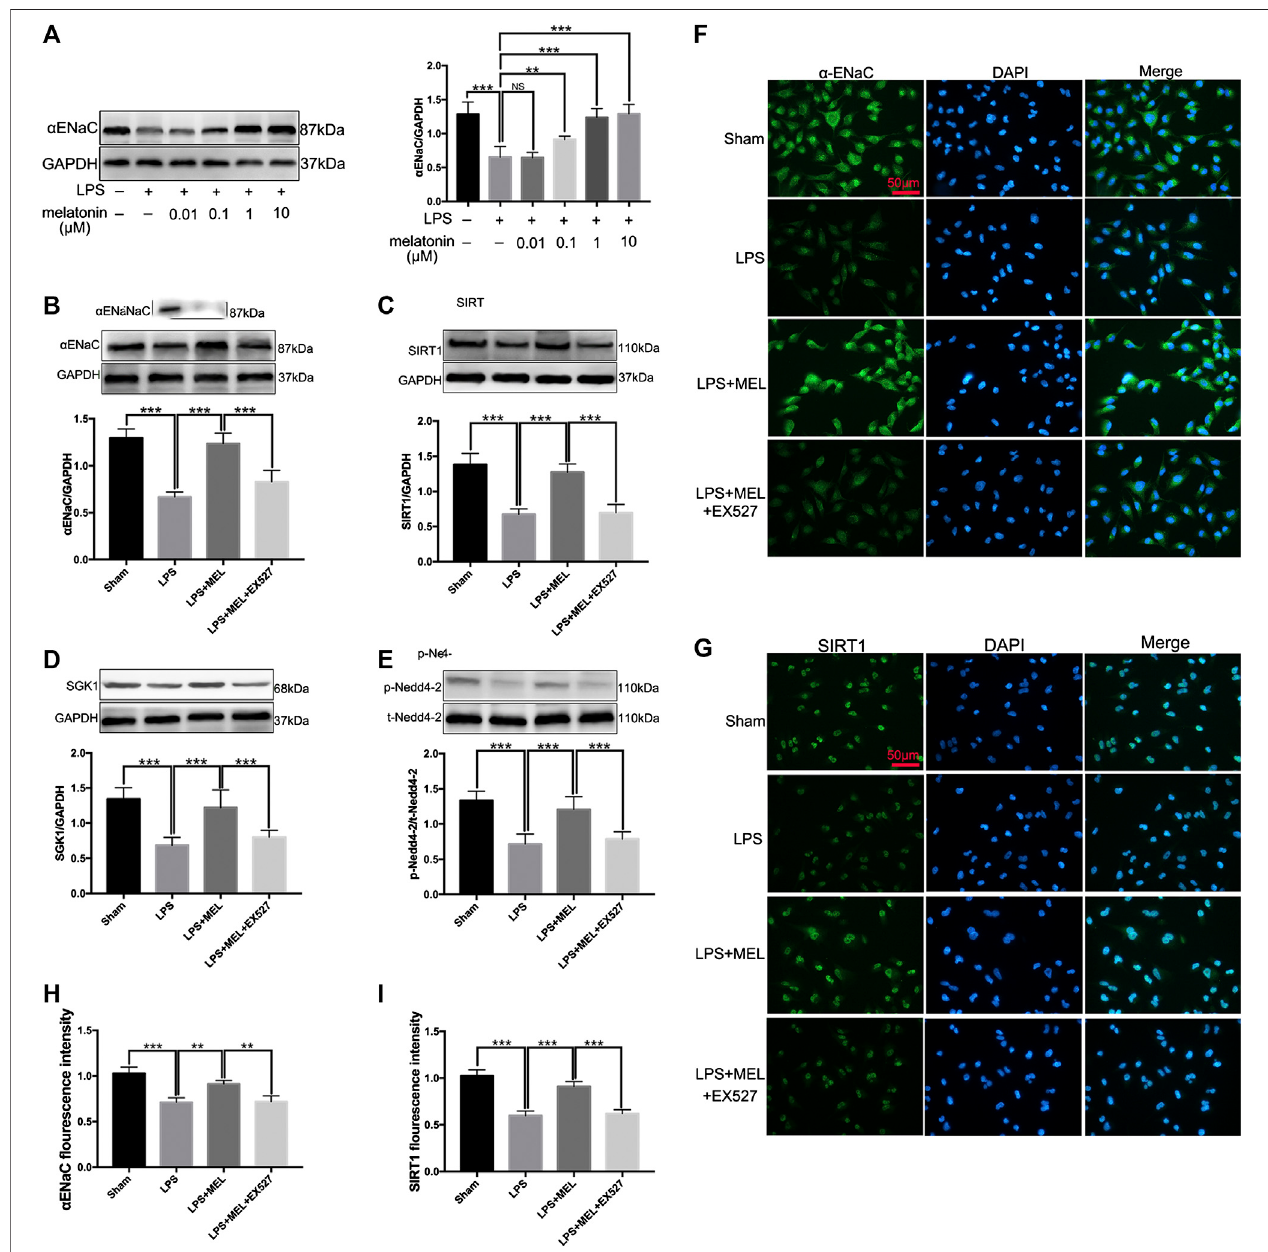
FIGURE6| Melatonin up-regulatedENaCproteinexpression throughSIRT1/SGK1/Nedd4-2pathway inA549cells. (A) A549CellswerestimulatedbyLPS(1 μ g/ ml) with differentconcentrations ofmelatonin (10, 100 nM,1and 10 μ M) for 24 h (B – G) A549cells were treatedwith LPSin thepresence or absence ofmelatonin (1uM) for 24 h. Inhibitor of SIRT1, EX527 (1uM) was administrated 1 h before melatonin. (B – E) The protein expression levels of α ENaC, SIRT1, SGK1 and Nedd4-2 were measuredby western blotusing GAPDHas aloading control. Results obtained bydensitometry ratios oftarget proteins to GAPDH. All valuesare means ± SD (n (cid:1) 6). NS, no signi fi cance, *** p < 0.001; ** p < 0.01; * p < 0.05 (one-way ANOVA followed by Turkey post hoc test). (F, G) α ENaC and SIRT1 were determined by immuno fl uorescence (H, I) Fluorescence intensity of SIRT1 and α -ENaC was determined by using ImageJ software (version 1.46, NIH, Bethesda, MD, USA, and all values were normalized to sham. All values are means ± SD ( n (cid:1) 4). *** p < 0.001; ** p < 0.01; * p < 0.05 (one-way ANOVA followed by Turkey post hoc test).